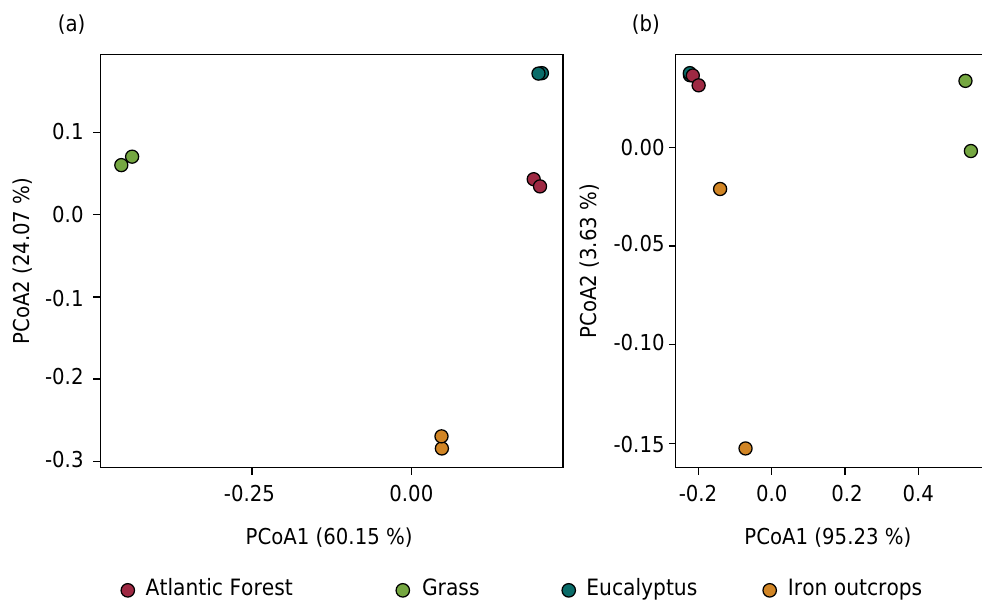
Figure 1. Weighted Unifrac distances of total fungi (a) and only yeast diversity (b). Colors correspond to each sampled ecosystem. Grass represents the “Rehabilitated area with